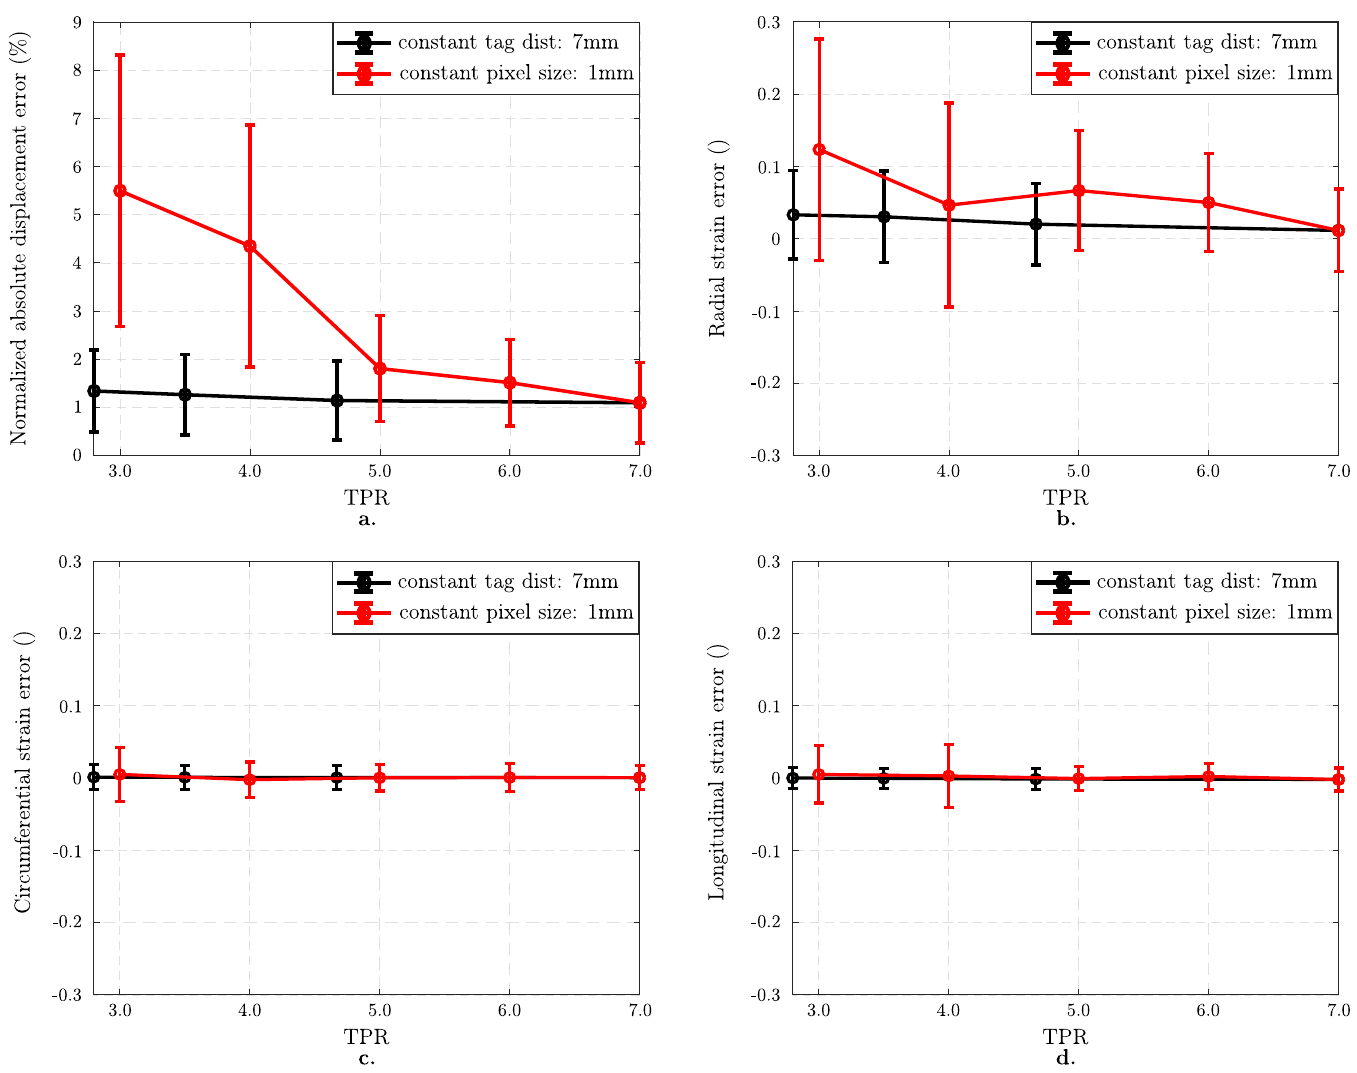
Fig 4. Effect of Tag distance to Pixel size Ratio (TPR) on noiseless isotropic image analysis. Normalized mean ± standard deviations in displacement error norm (%) plotted as a function of TPR (a). Black curve stands for the errors computed for the images with different pixel sizes keeping the tag distance constant at 7 mm while the red one represents the analysis results with different tag distances where the pixel size is 1 mm. Mean ± standard deviations in component-wise Green-Lagrange strain error as a function of TPR for the best performing regularization strength (b-d). Radial strain component (b) is more sensitive to a change in TPR while the circumferential (c) and the longitudinal (d) components are more accurately